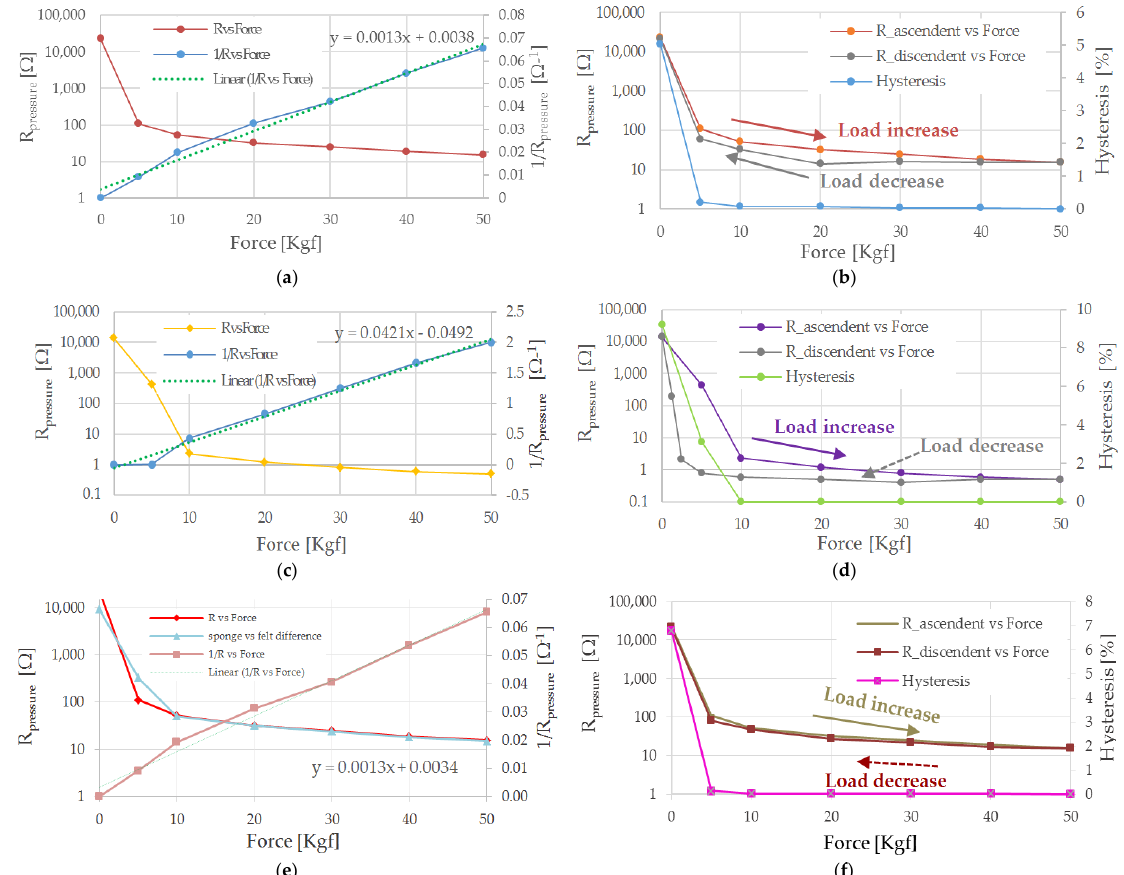
Figure 18. Characteristics of sensor 6 for different support material: rigid support ( a ), sponge ( b ), and felt insoles ( c ). For each support, the trend of R pressure as a function of the applied force (in logarithmic scale), from 0 Kgf to 50 Kgf, has been determined ( a , c , e ), along with the inverse of R pressure ; besides, the responses of sensor 6 to ascending and descending loads were shown ( b , d , f ), along with the hysteresis trends.